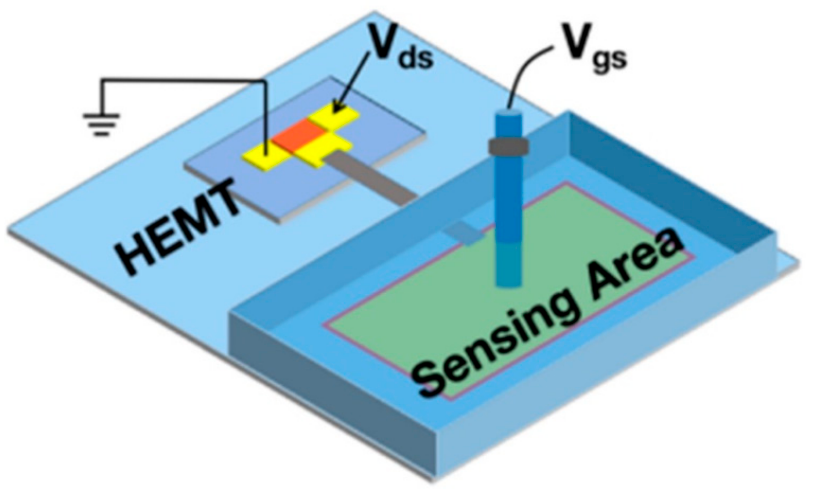
Figure 4. The example structure of an extended gate biosensor. Reprinted from reference [125]. Copyright 2022, with permission from Elsevier .